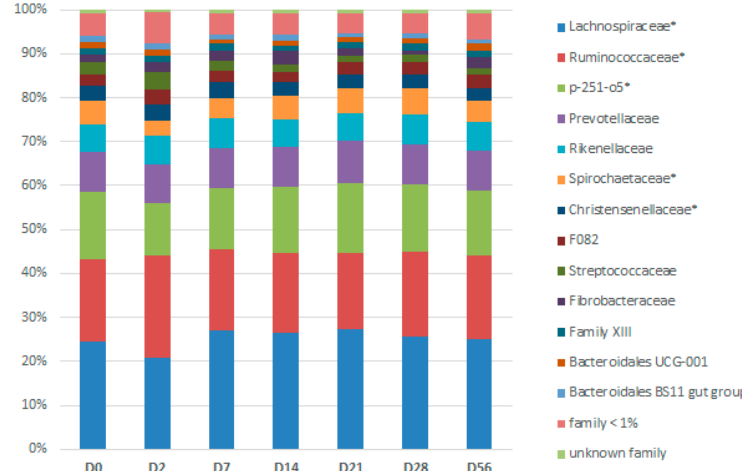
Figure 6. Days (D)-related bacterial modifications at the family level during two consecutive dietary changes from high-fiber (HF) to high-starch (HS) diet and vice versa. The relative abundance of families with star superscripts (*) differed significantly between days.